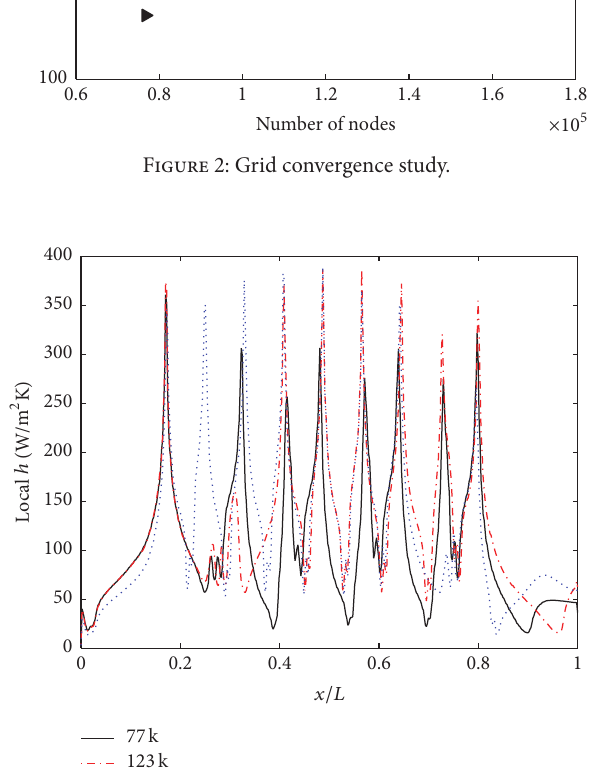
Figure 3: Local ℎ as a function of normalized distance 𝑥/𝐿 from the sheet entrance region for three resolutions of the grid.